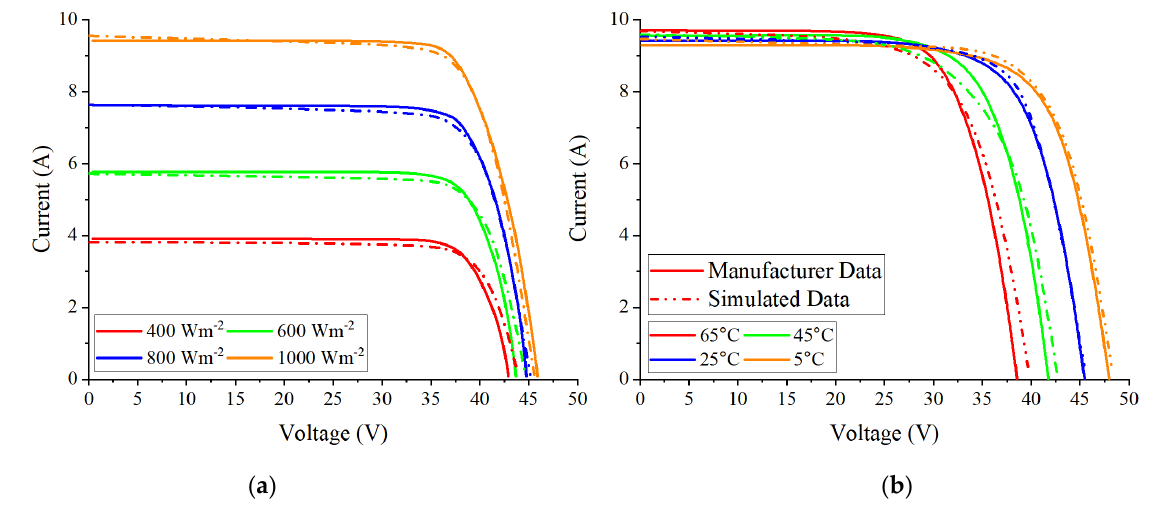
Figure 2. Comparison of PV panel characteristics from manufacturer data in [17] (solid lines) and the simulation model (dash-dot lines), for I–V characteristics, at ( a ) different solar irradiance levels; ( b ) different ambient temperatures. Table 2. Electrical characteristics of modelled PV panel from [17].